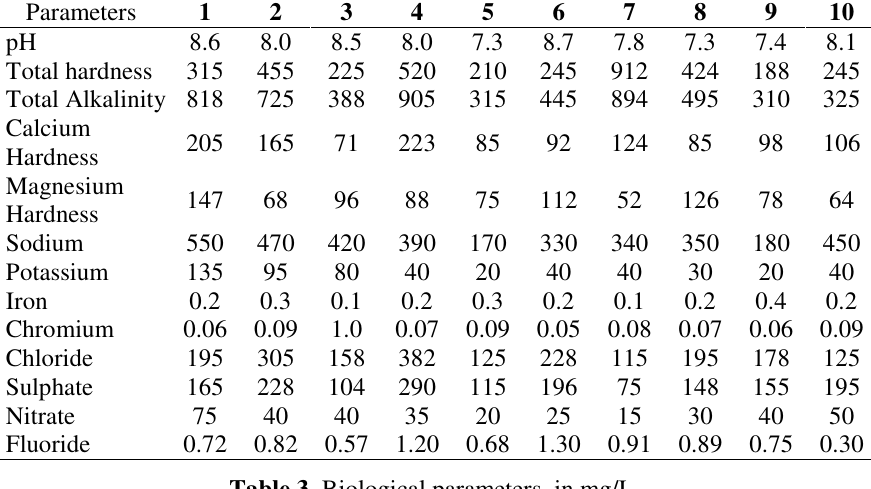
Table 2. Chemical parameters, in mg/L.